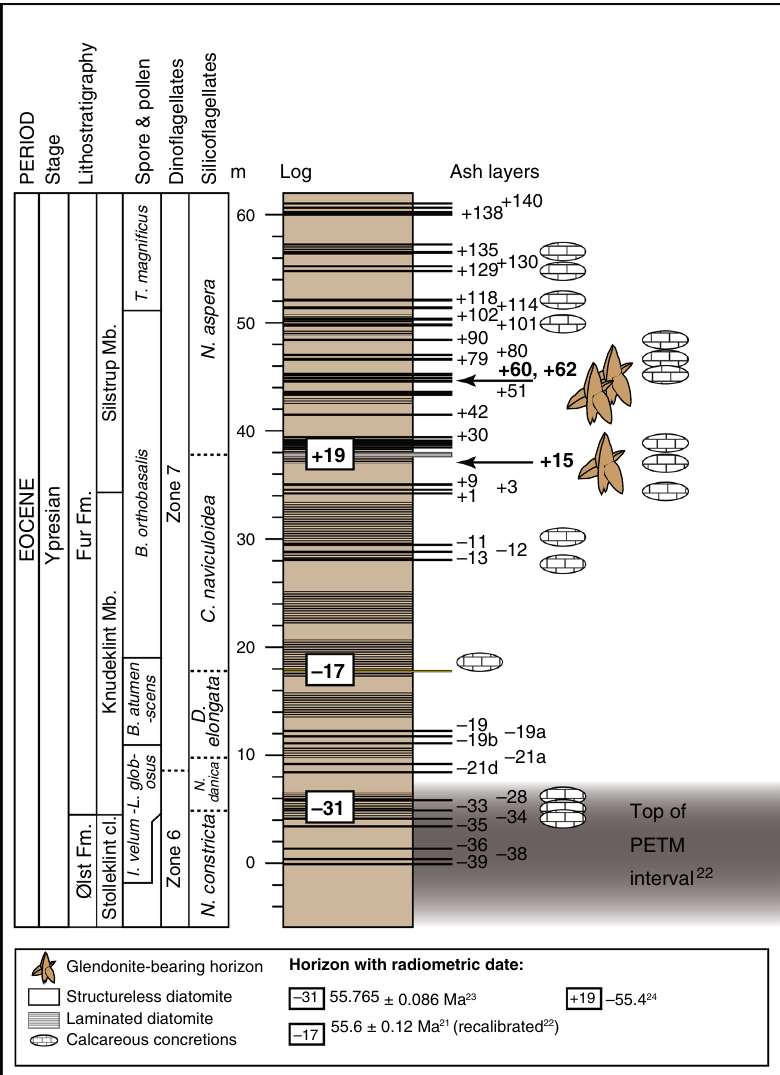
Fig. 2 Idealised graphic log for the Fur Formation. The numbers (e.g. + 15, − 39) refer to the ash layers. The PETM interval lies 24 m below ash layer − 33. Dated ashes from Storey et al. 21 , Westerhold et al. 24 , and Charles et al. 23 . Spore and pollen zones from Willumsen 77 , dino fl agellate cyst zones from Heilmann-Clausen et al. 86 and silico fl agellate zones from Perch-Nielsen 87 . Fm.